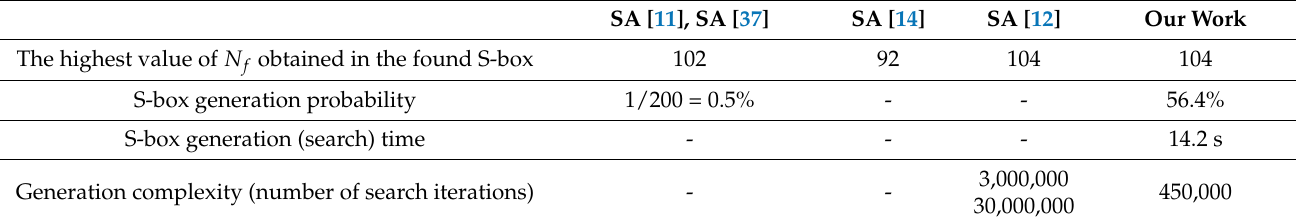
Figure 23. Average time (s) of the target S-box generation when α = 0.85; 0.9; 0.95 and k int = 650 (each point is the average of 1000 tests). Table 2. Comparison of the results obtained on the generation of bijective 8-bit S-boxes (for different implementations of the SA